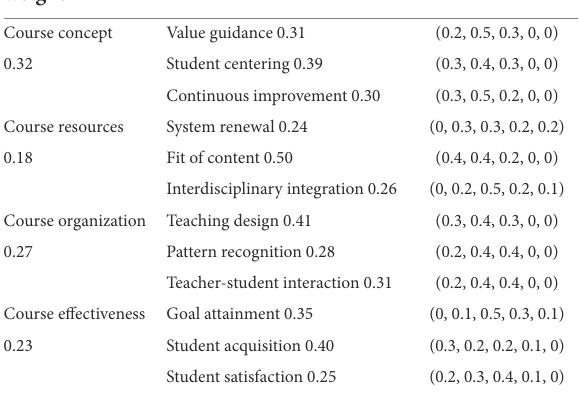
TABLE 7 Weight and membership degree of each indicator of quality evaluation of “Management”